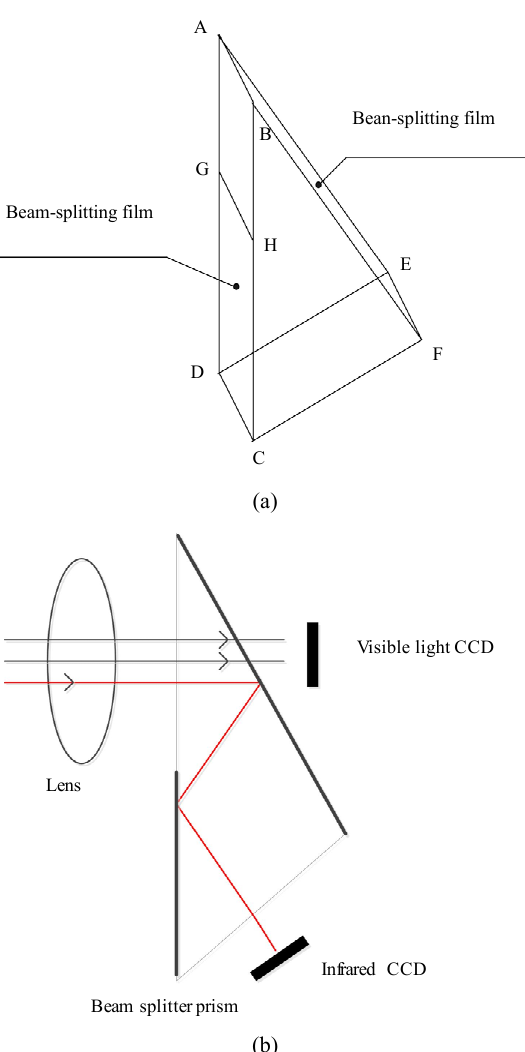
Fig. 2 Beam splitter prism: (a) the structure of the beam splitter prism and (b) principle of the beam splitter